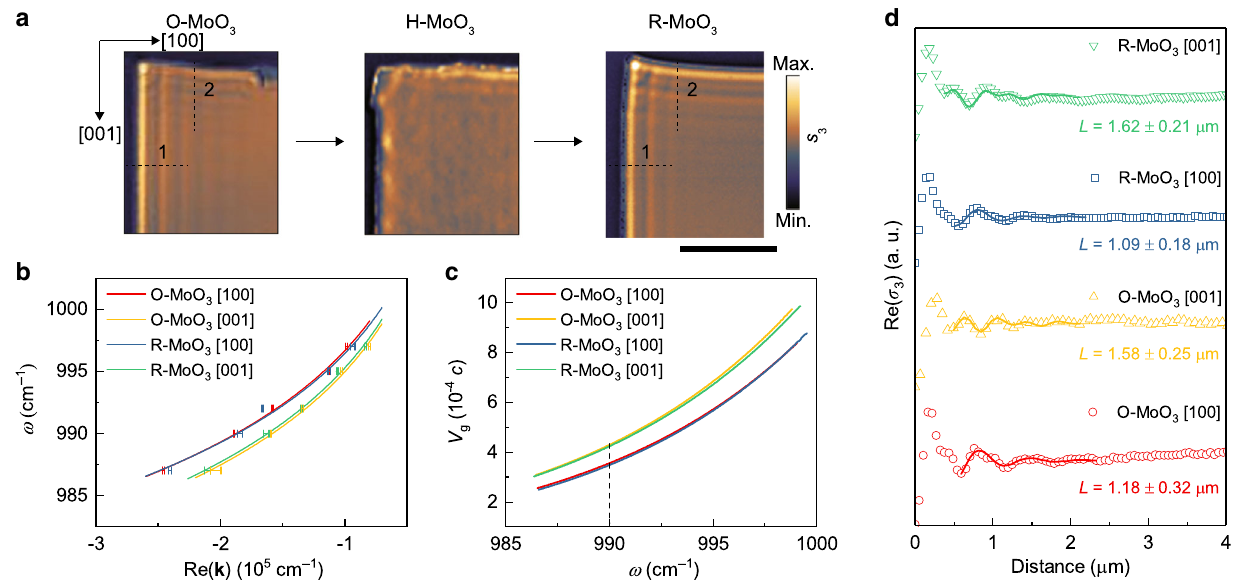
Fig. 3 Reversible switching of PhPs in the U-RB of α -MoO 3 . a Optical micrographs and s-SNOM amplitude images (990 cm − 1 ) of original, intercalated, and recovered MoO 3 fl akes. Scale bar = 5 μ m. b PhP dispersion data and fi tting results (solid lines) along both [100] and [001] directions (dashed lines in a ). The error bars represent the 95% con fi dence intervals. c Group velocities of PhPs extracted from the fi tting results in b . d Comparison and fi tting (solid lines) of extracted line